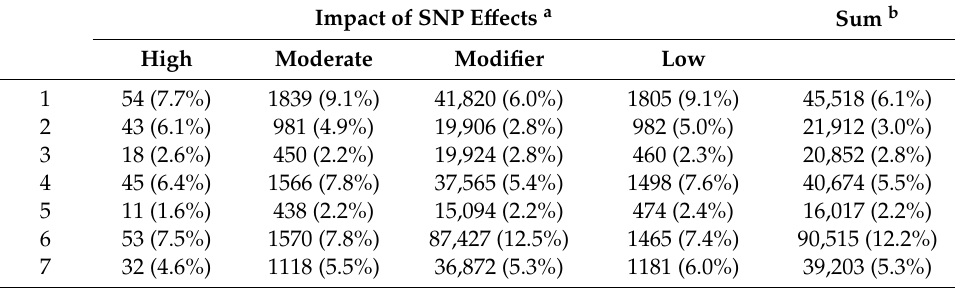
Table 1. Classification of single nucleotide polymorphisms (SNPs) by predicted e ff ects on gene